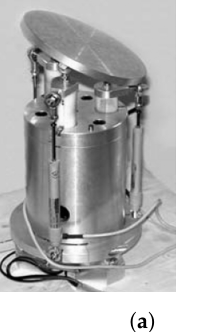
Figure 6. From the left, ( a ) a first prototype of the mini-manipulator in a three-dimensional view and ( b ) the functional scheme with the basic